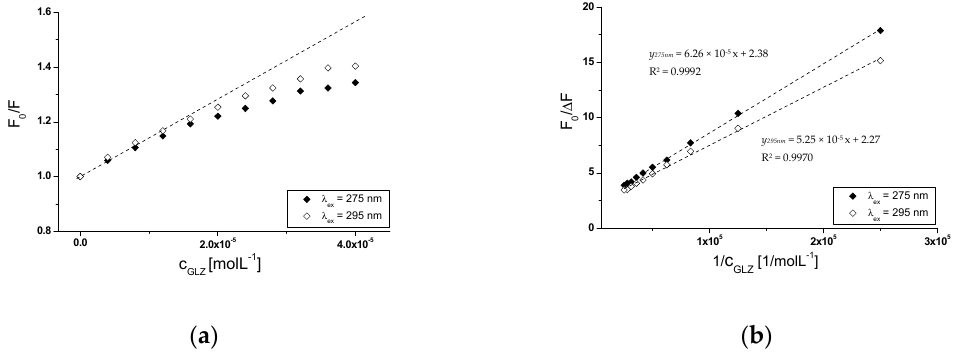
Figure 12. ( a ) The Stern-Volmer curves and ( b ) the Stern-Volmer curves modified by Lehrer for GLZ-(gHSA FRC -PIR) system; λ ex = 275 nm and λ ex = 295 nm; the error bars are smaller than the symbols.